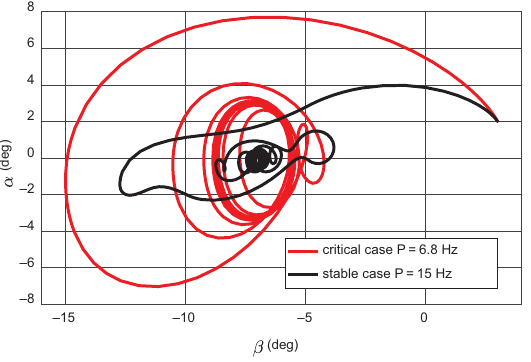
Figure 15. Diameter of limit cycle in critical and nominal roll